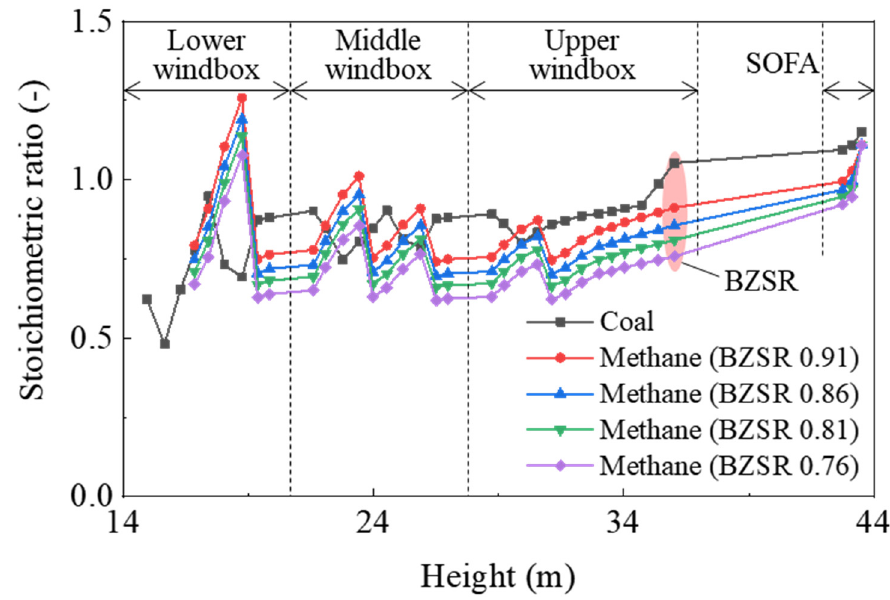
Figure 3. Stoichiometric ratio as a function of furnace height in each case investigated. BZSR: burner zone stoichiometric ratio.